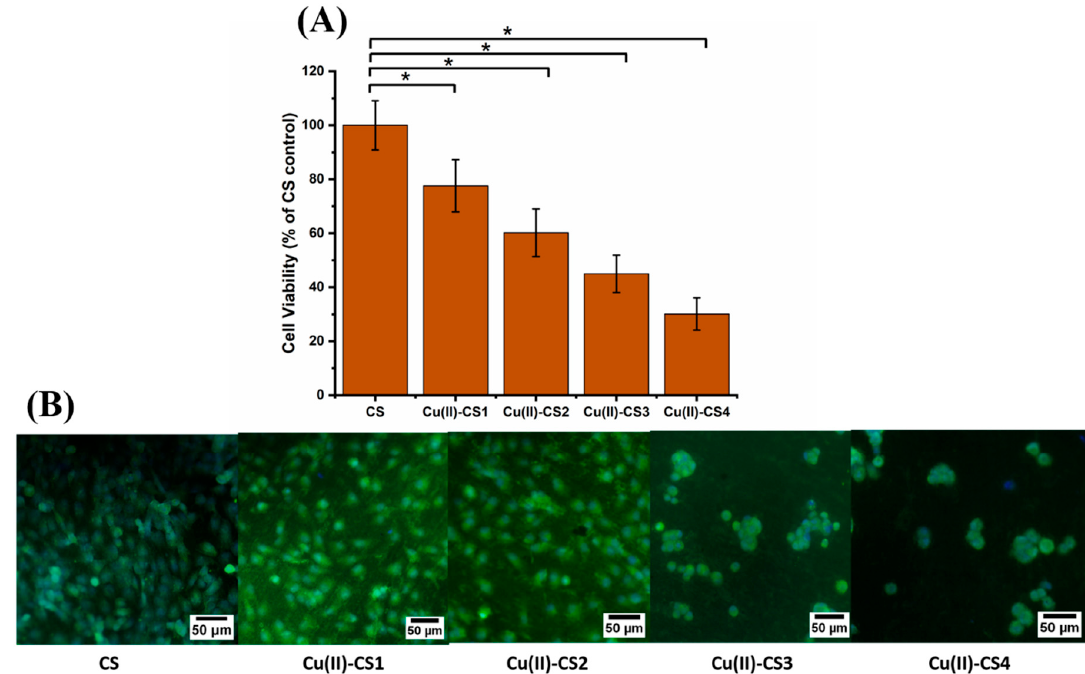
Figure 11. ( A ) Graph representing MG-63 cell viability (WST-8 assay) on different